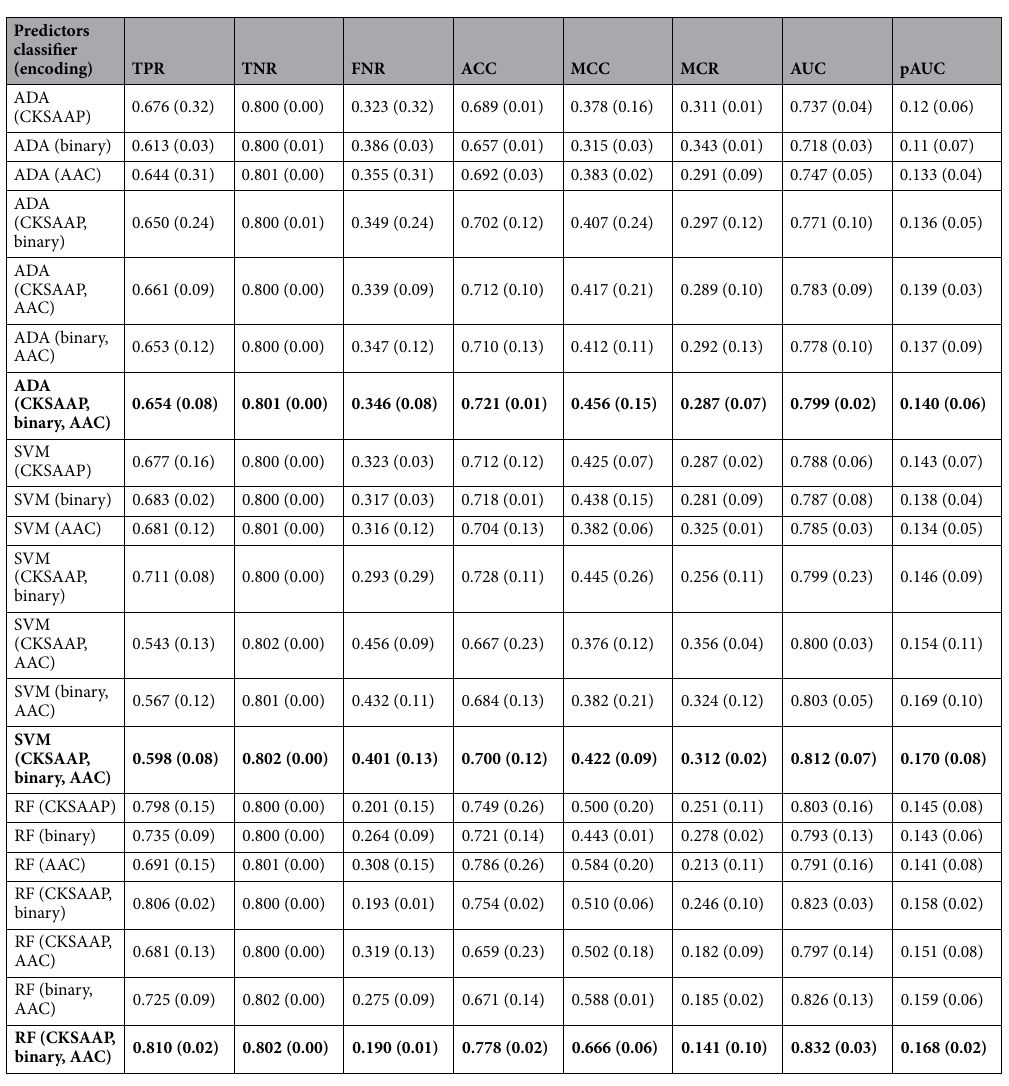
Table 2. Performance scores at FPR = 0.20 for 21 prediction models by 5-fold CV with the training dataset that was consisted of 1:2 ratio of positive and negative samples. Better results with each of ADA, SVM and RF were highlighted by bold values. The values within the first bracket indicate the standard error